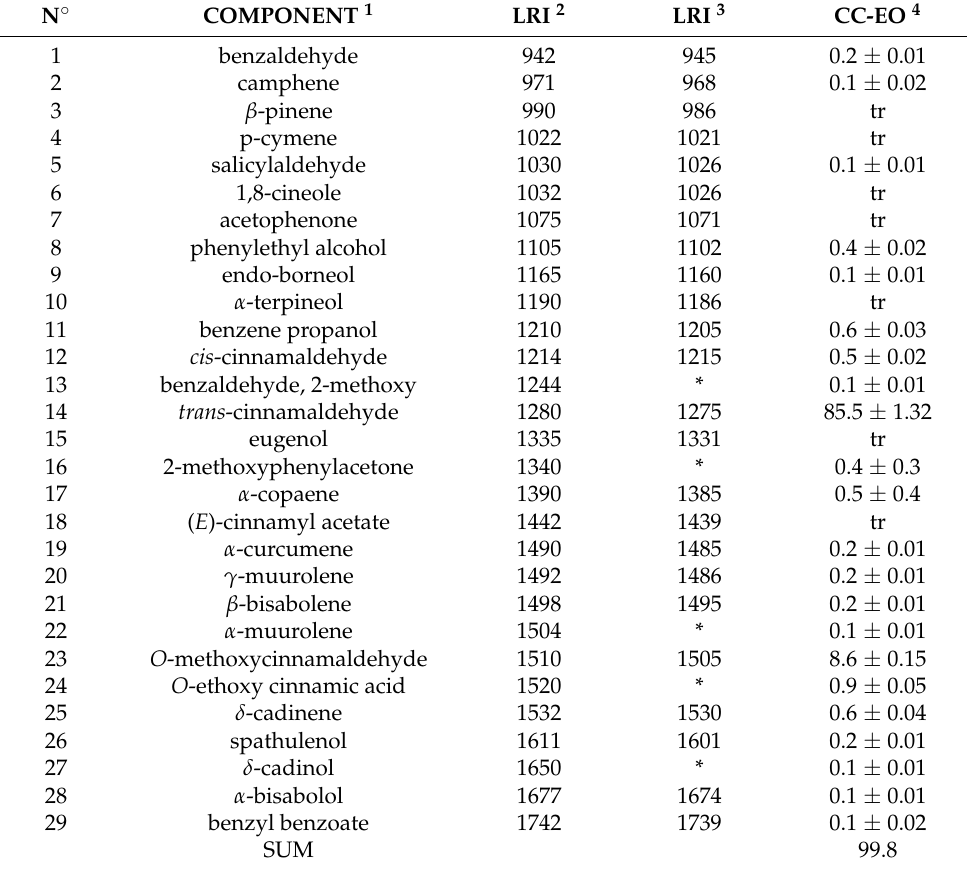
Table 2. Chemical composition (relative percentage mean values ± standard deviation) of C. cassia